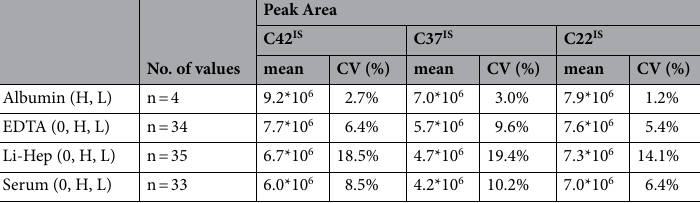
Table 4. Mean peak areas and precisions of internal standards in different biological matrices. Different CAAP concentrations were spiked into each of the individual matrices: 0 = pure albumin; H: high CAAPs concentration; L: low CAAPs